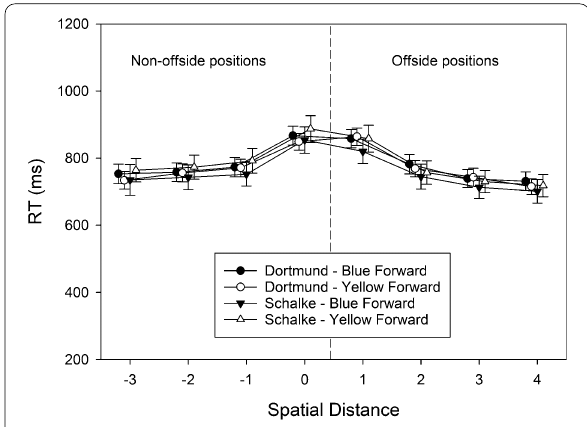
Fig. 7 The RTs of correct offside judgments observed in Experiment 2, plotted as a function of spatial distance (between forward and defender), participants’ team preference (Dortmund vs. Schalke), and shirt color of the attacking team (blue vs. yellow). Error bars represent standard errors between participants. For each level of spatial distance, data points are jittered to increase